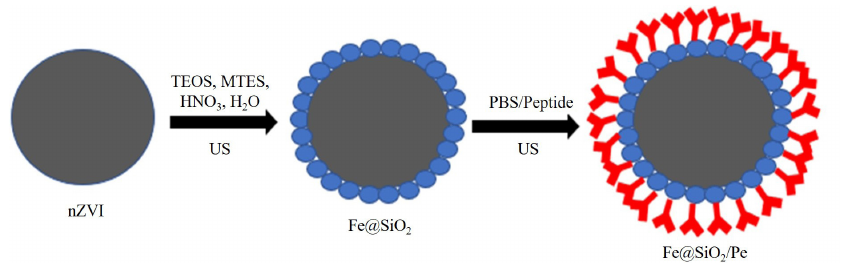
Figure 1. Scheme of the preparation of silica-coated zero-valent iron nanoparticles and subsequent functionalization of the peptide. US: Ultrasound. TEOS: tetraethylorthosilicate. MTES: methyltriethoxysilane. PBS: phosphate-buffer saline